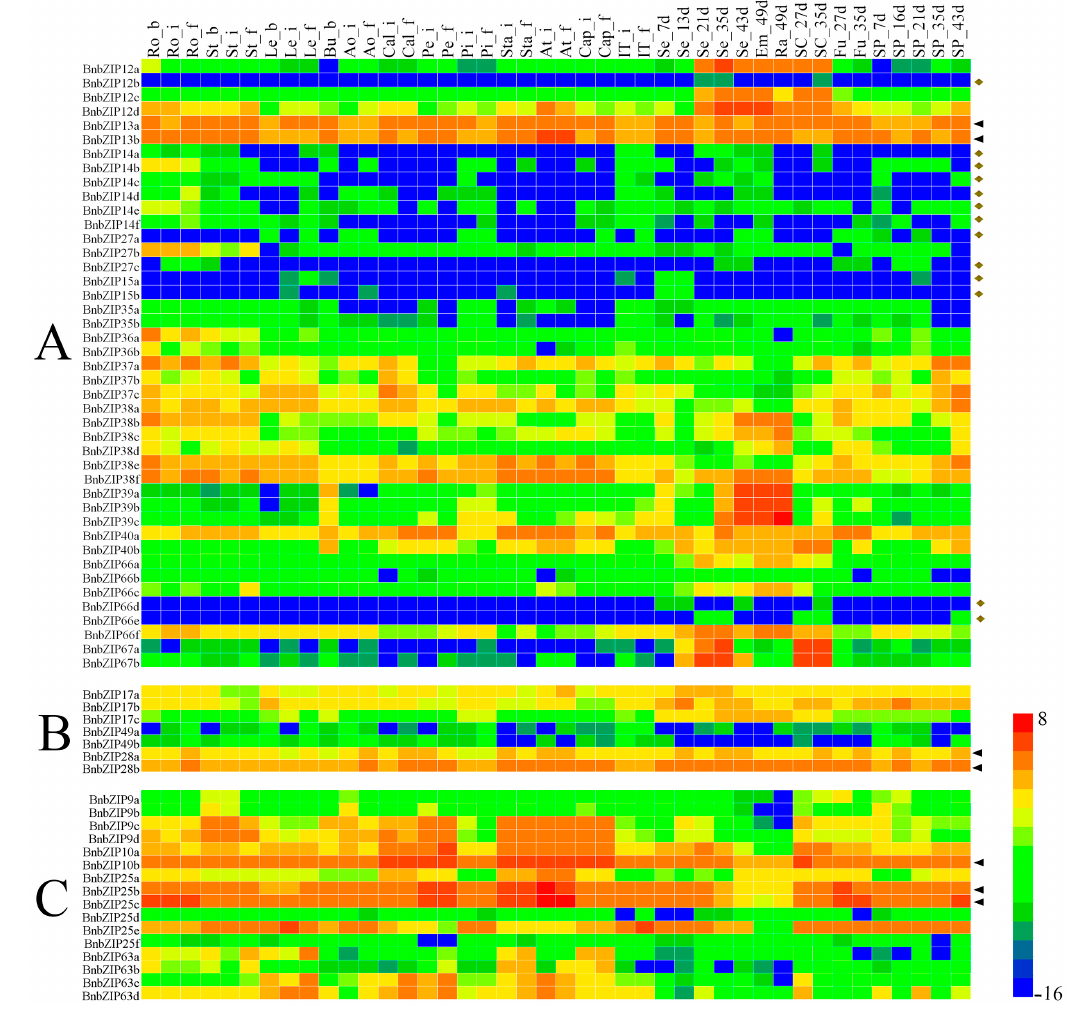
Figure 4. Distribution of BnbZIP gene family members on the B. napus chromosomes. The 222 BnbZIP genes for which exact chromosomal information is available in the database were mapped to the 19 B. napus chromosomes. Genes from the same subtribe are indicated by the same color, which is consistent with the corresponding family in the evolutionary tree. The scales were indicated the genome size of B. napus genome (Mb). A01-A10 and C01-C09 indicate the chromosomes